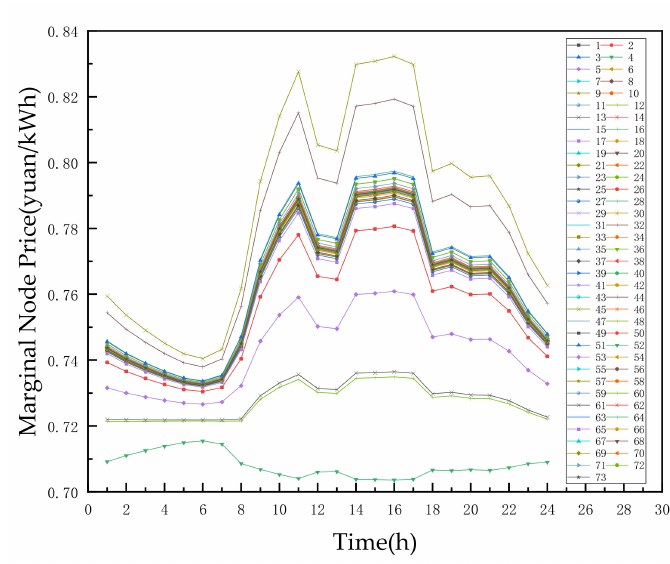
Figure 9. Marginal node price without considering the flexible load.